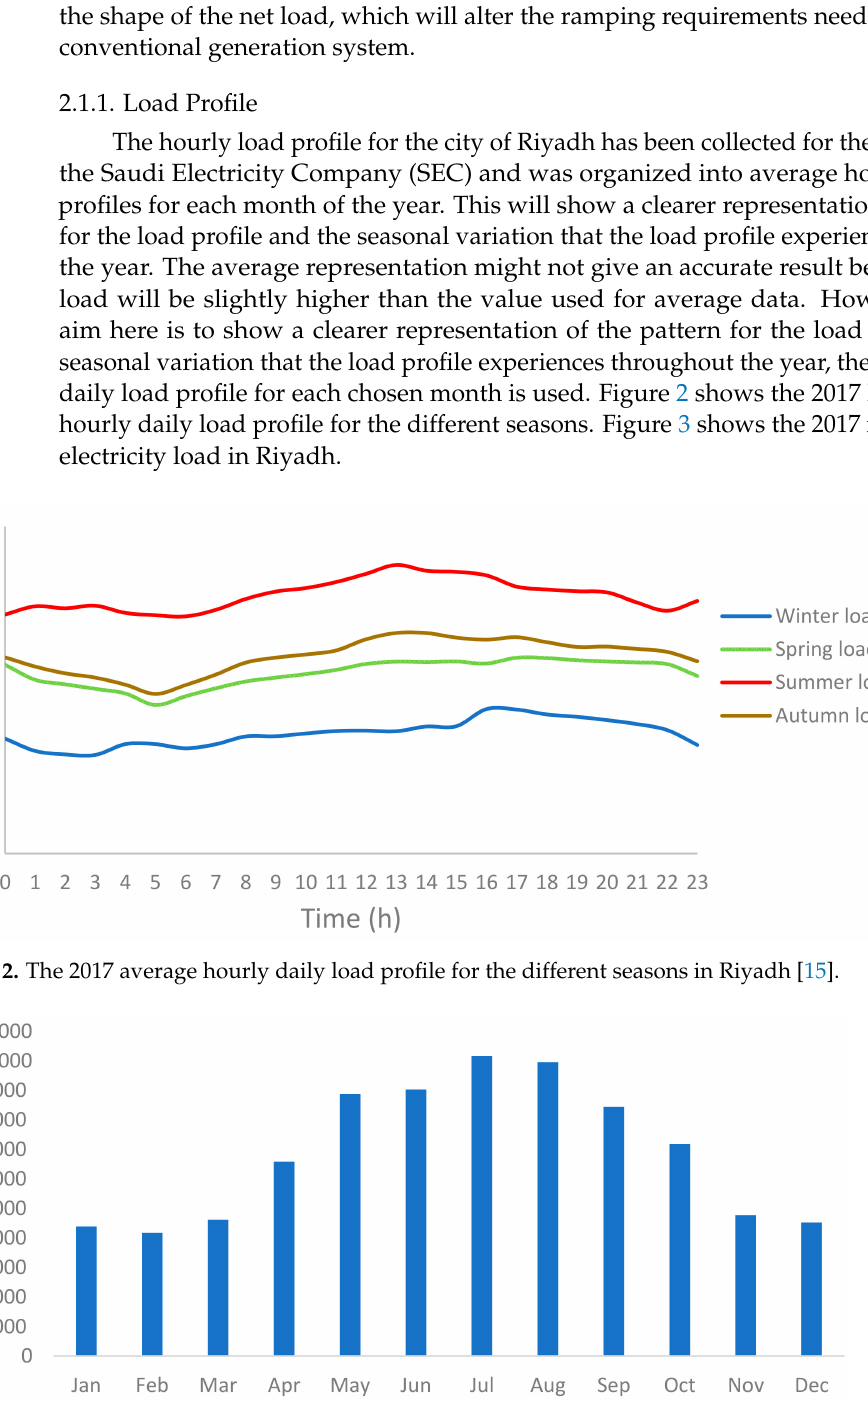
Figure 3. The 2017 monthly sum of electricity load in Riyadh